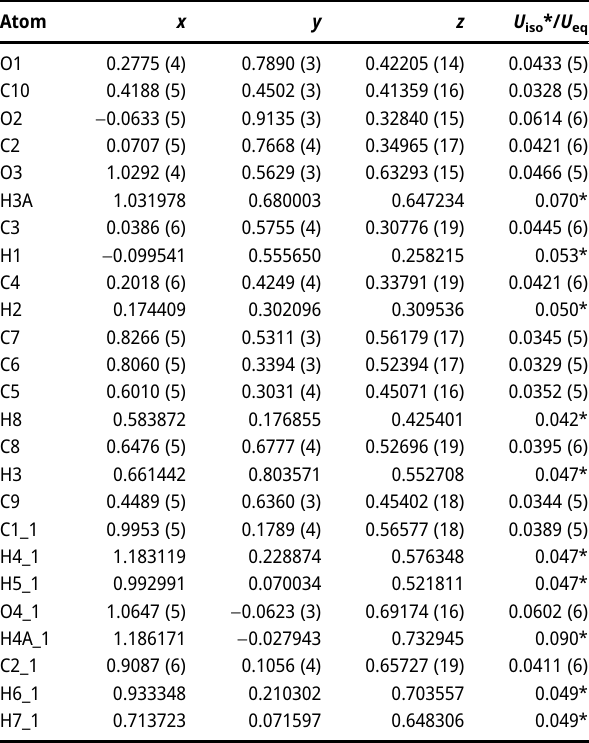
Table  : Fractional atomic coordinates and isotropic or equivalent isotropic displacement parameters (Å 